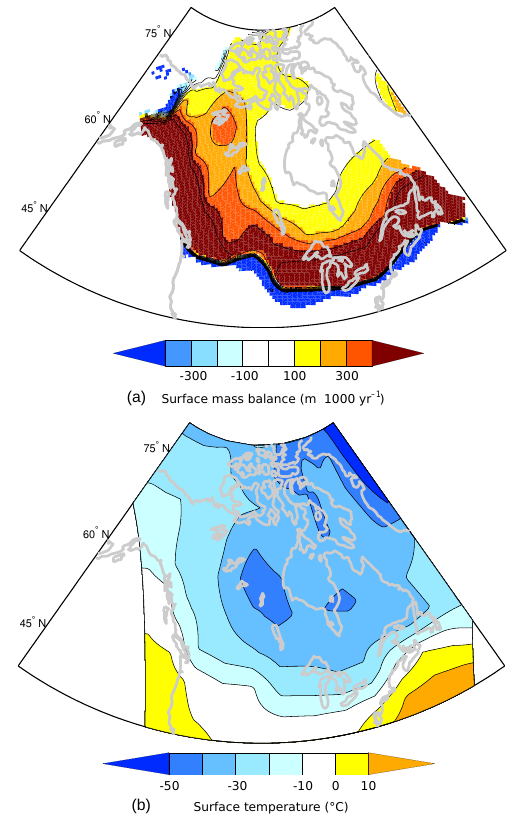
Figure 1. Ice sheet forcing fields. Panel (a) shows the annual av- erage surface mass balance field and panel (b) the annual average surface temperature